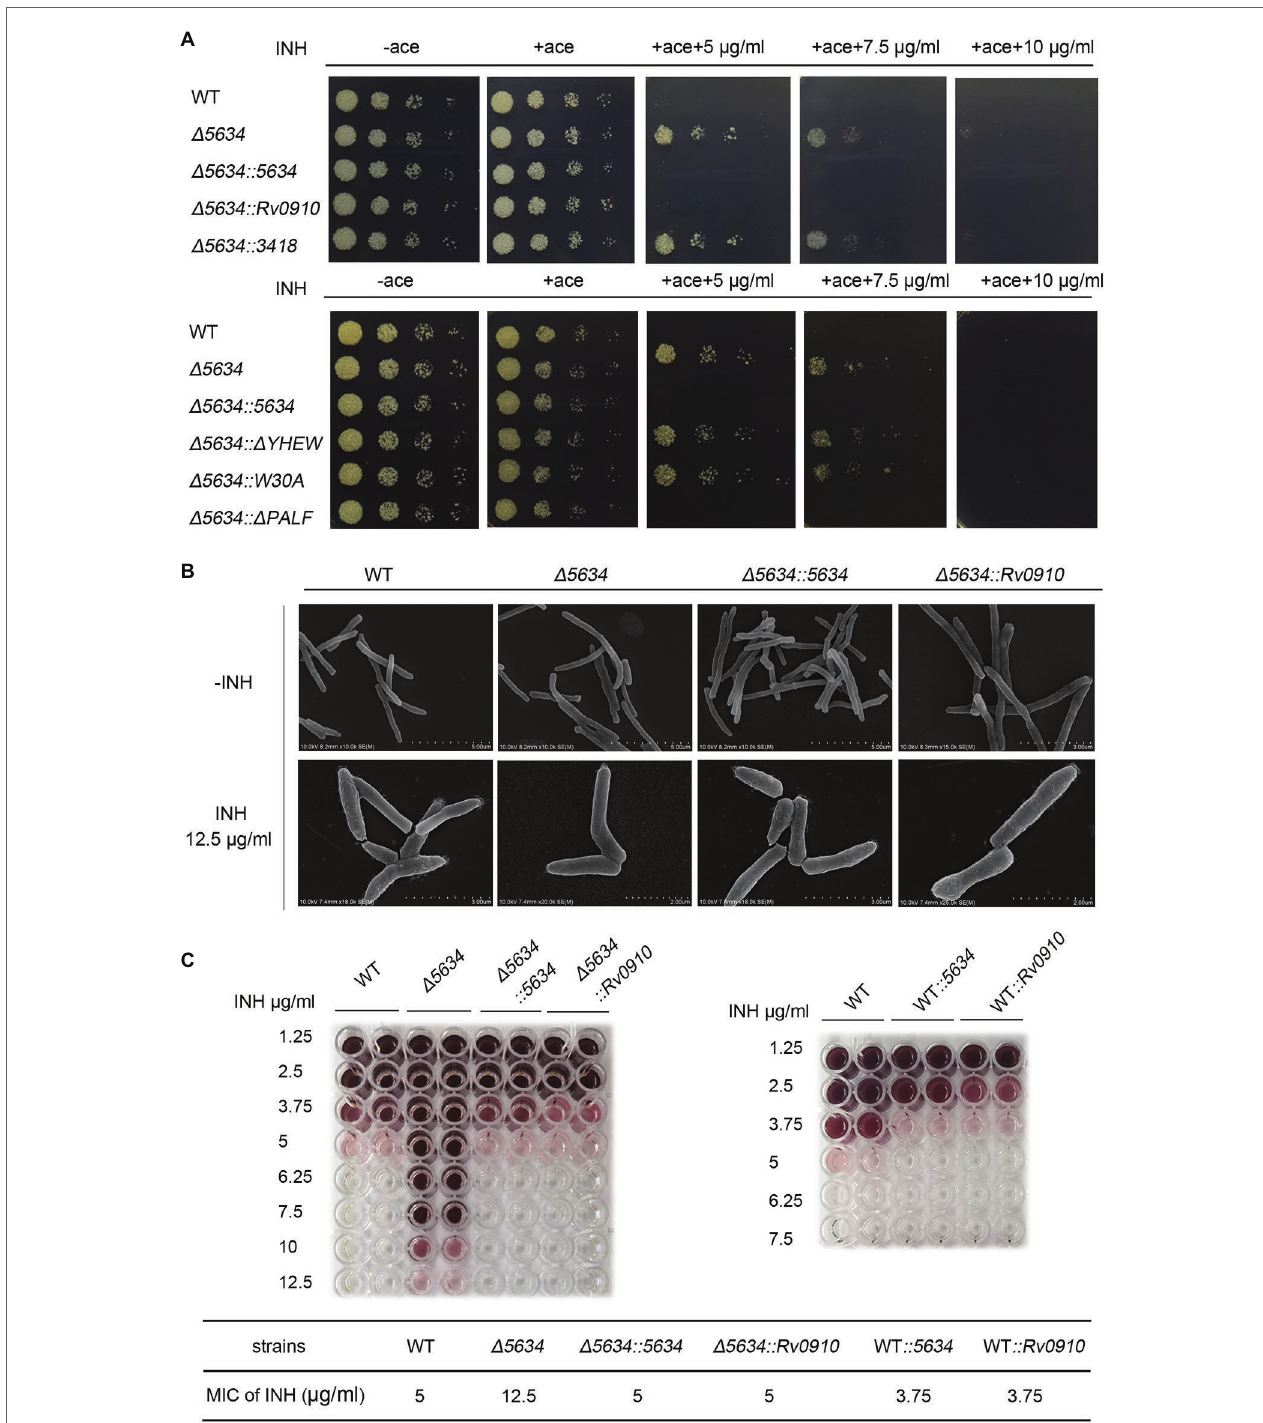
FIGURE 6 | The impacts of MSMEG_5634 on the isoniazid sensitivity in Mycobacterium smegmatis . (A) The indicated M. smegmatis cells were serially diluted and grown on 7H10 solid medium with different concentrations of isoniazid (INH) in the presence or absence of acetamide (0.2%). The cells untreated with isoniazid were cultured for 48 h, and the cells treated with INH were cultured for 72 h. (B) Morphology detection by scanning electron microscopy. The indicated M. smegmatis strains were treated with 12.5 μ g/ml INH for 12 h in the presence of acetamide (0.2%). (C) The minimum inhibitory concentrations of INH to different strains. The indicated strains (1 × 10 5 cells/well) were cultured in 7H9 medium for 24 h at 37 ° C under INH treatment at different concentrations in the presence of acetamide (0.2%) with TTC (0.02%) as the indicator. WT, the wild-type cells containing empty pACE vector; Δ 5634 , the MSMEG_5634 -deleted cells containing empty